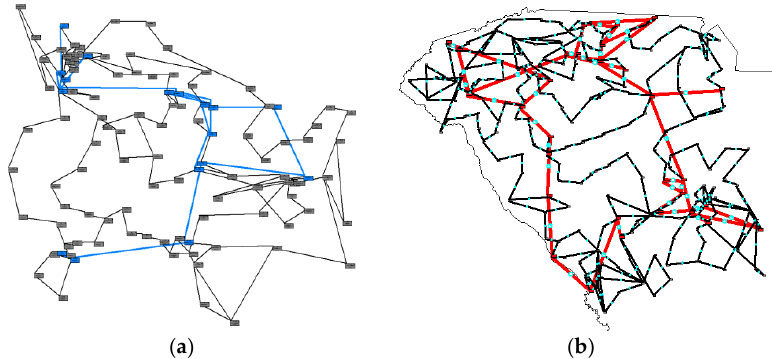
Figure 8. ( a ) One-line diagram of the ACTIVSg200 test case, with 230 kV lines in blue and 115 kV lines in black. ( b ) One-line diagram of the ACTIVSg500 test case, with 345 kV lines in red and 138 kV lines in black.